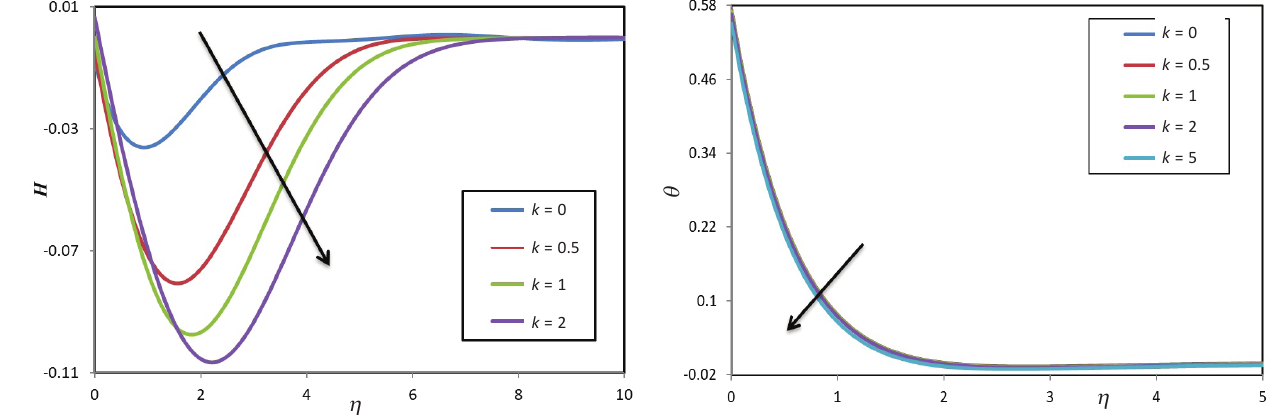
Fig. 13 – θ (temperature) versus h for I = 0.5, F = –0.5 (heat sink), Pr = 100 (weak polymers), m = 0.3 (general wedge flow), Ec = 0.2, with K = 0 (Newtonian), 0.5, 1, 2,